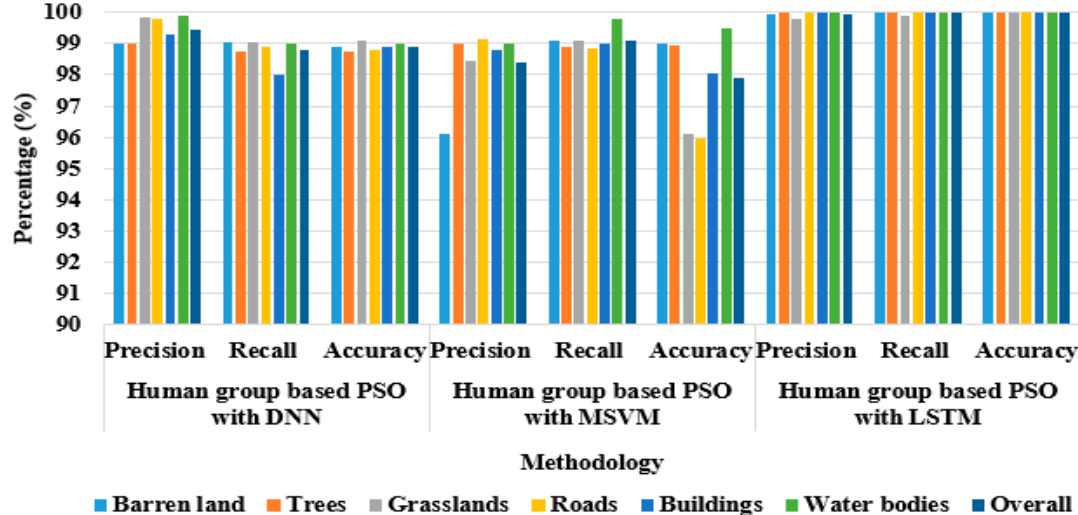
Table 12. Performance investigation of the proposed model with different optimization techniques on Sat 6 dataset by means of classification accuracy. Figure 11. Graphical investigation of the proposed model with different classifiers on Sat 6 dataset. Figure 11. Graphical investigation of the proposed model with di ff erent classifiers on Sat 6 dataset.